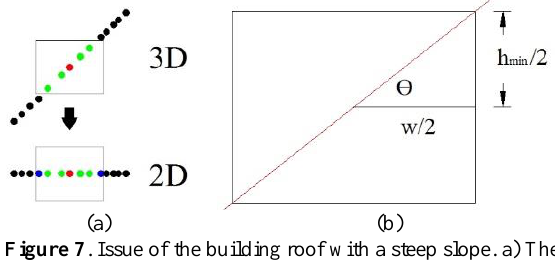
Figure 7 . Issue of the building roof with a steep slope. a) The difference between the number of neighborhood points in the 3D and 2D space, b) The relationship between the minimum height, width, and the inclination angle of the roof. The red line is the building roof. The red, green, and blue points represent the interest, the neighborhood, and the new points in 2D space, respectively.